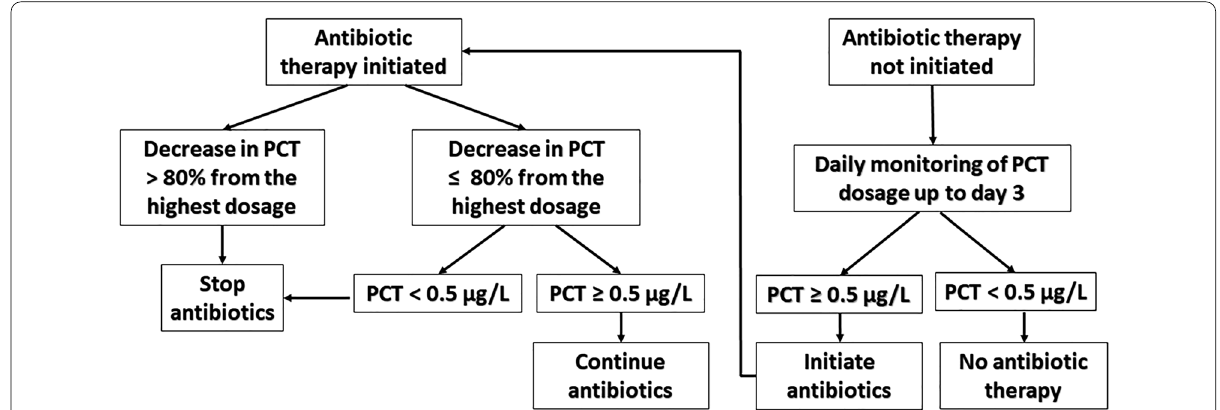
Fig. 2 Decisional algorithm for the discontinuation of antibiotic therapy and patient